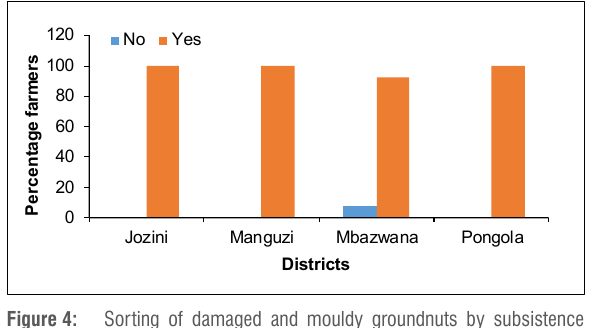
Figure 4: Sorting of damaged and mouldy groundnuts by subsistence farmers in four districts of northern KwaZulu-Natal (chi-square: d.f.=3; p =0.610).